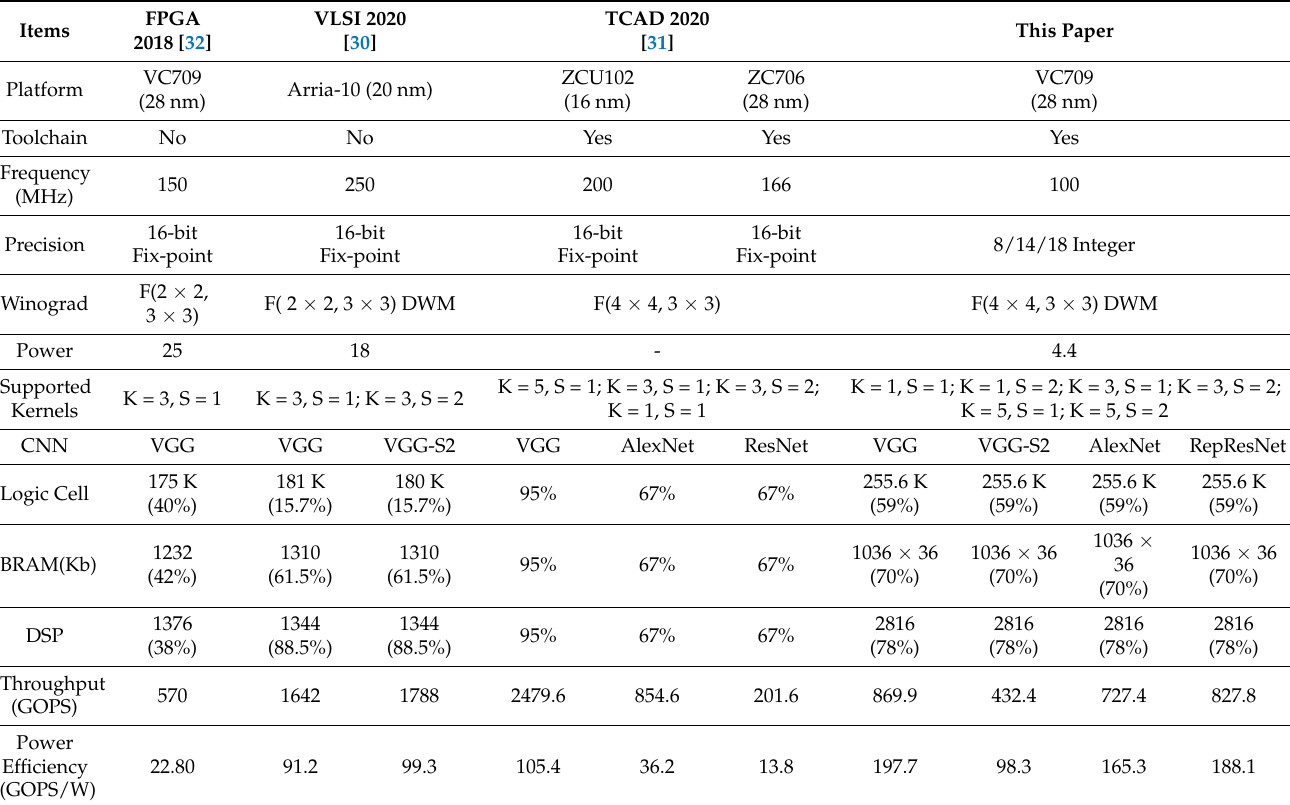
Table 5. Comparison between FPGA-based CNN accelerator with